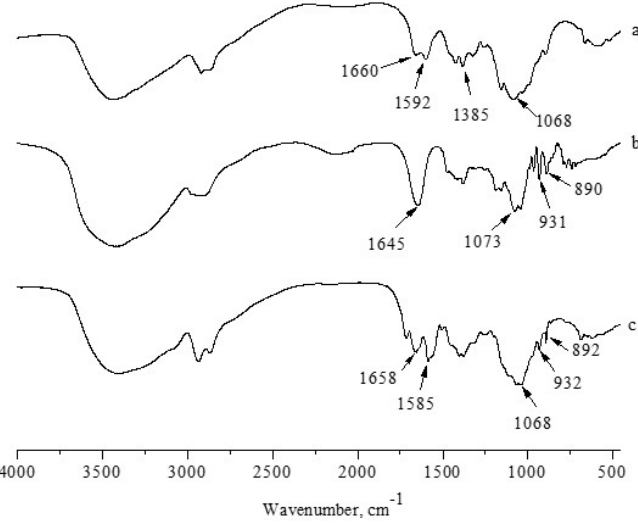
Figure 3. FTIR-ATR spectra of ( a ) chitosan; ( b ) agarose; and ( c ) chitosan–agarose composite film with an agarose mass concentration of 60%.